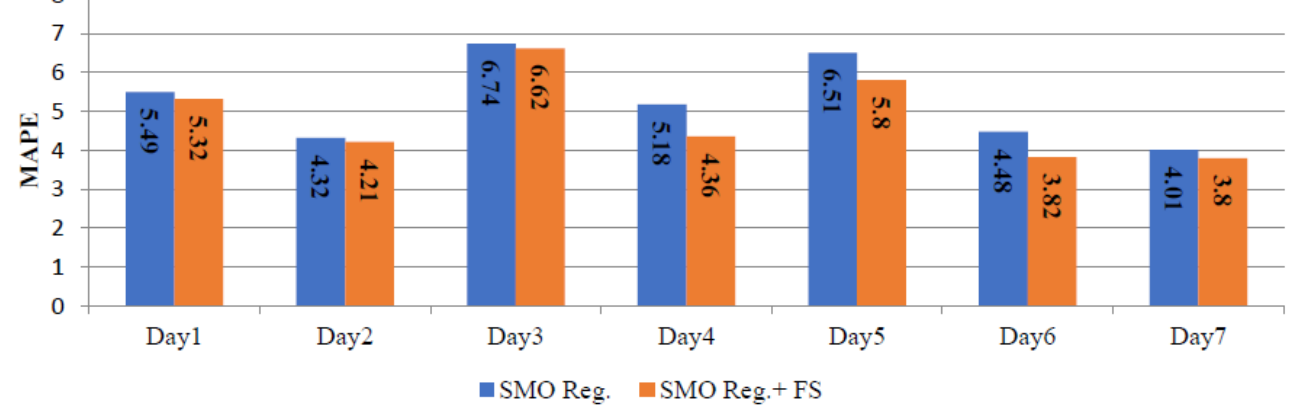
Figure 7. Daily MAPE corresponding to SMO reg. and SMO reg.+ FS for spring season.